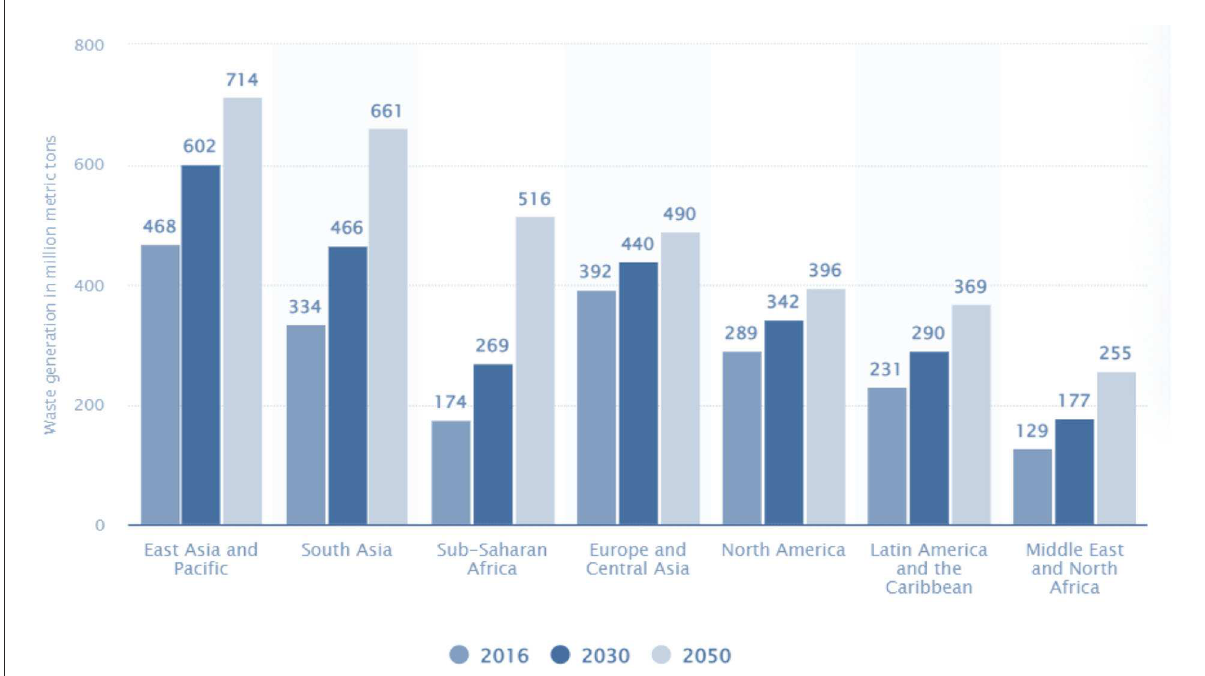
FIGURE1 Projection of waste generation worldwide in 2016, 2030, and 2050 by region in million metric tons (Statista,